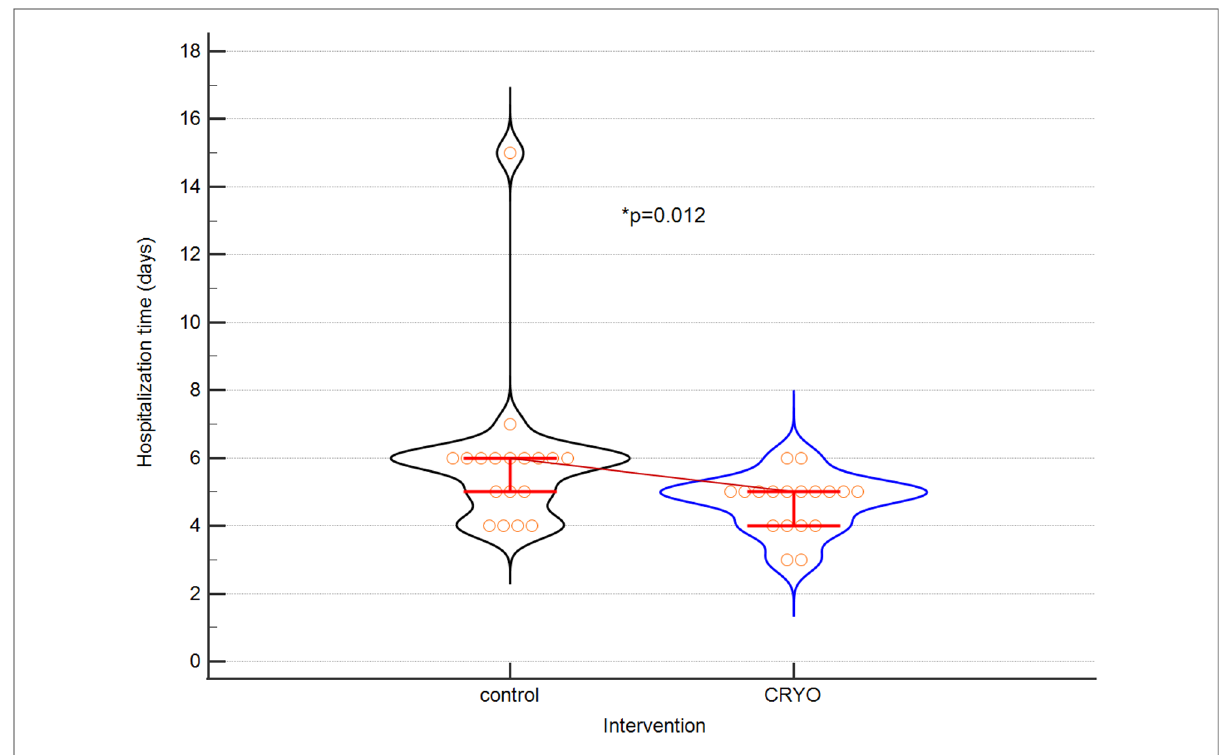
FIGURE 1 Course of the